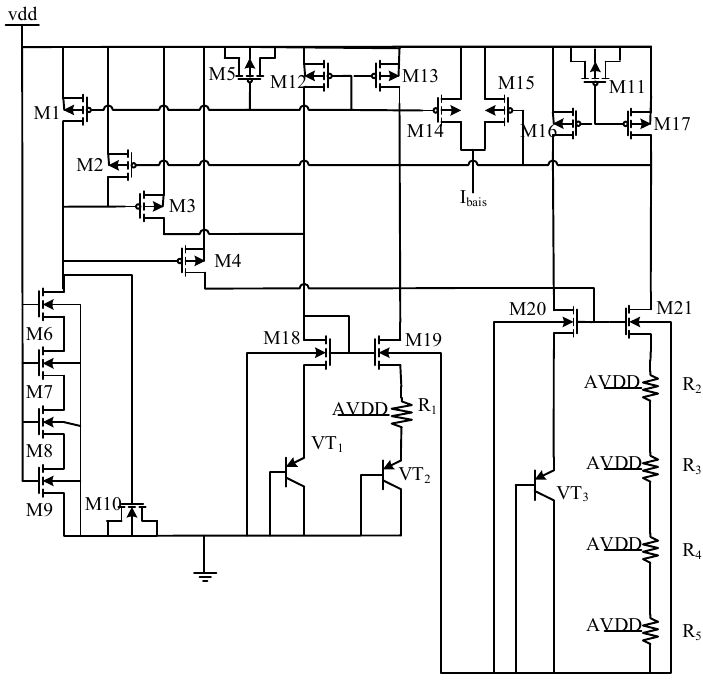
Figure 7. Circuit diagram of the reference voltage source.